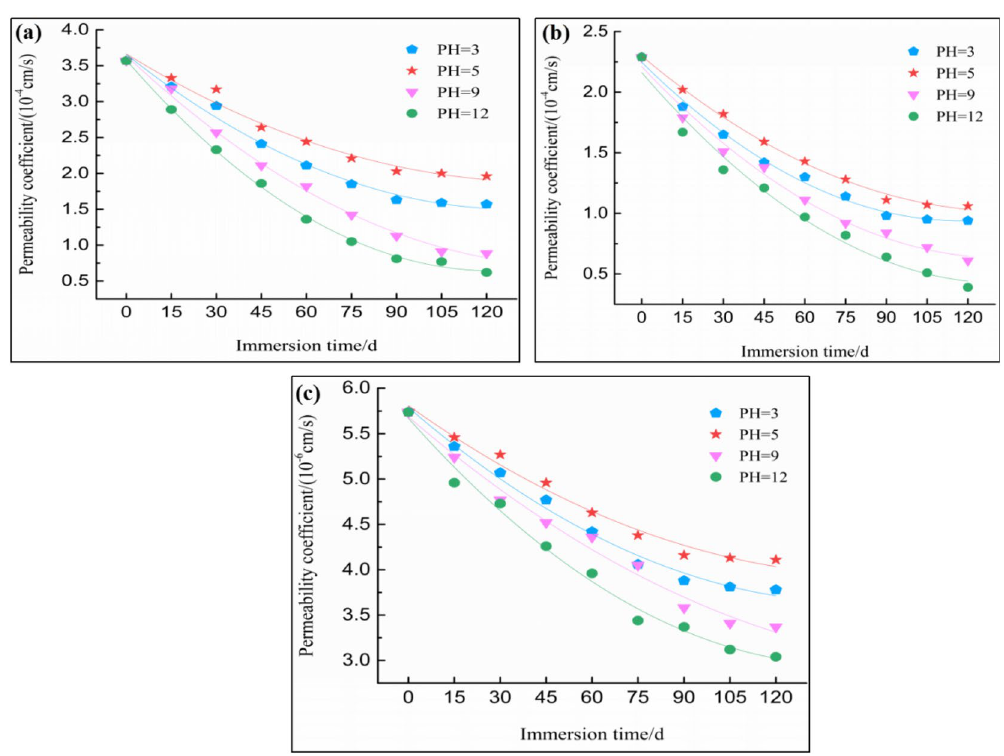
Figure 2. The relationship between the permeability coefficient of tailings and immersion duration. ( a ) Tailing silty sand; ( b ) Tailing silty soil; ( c ) Tailing silty clay.